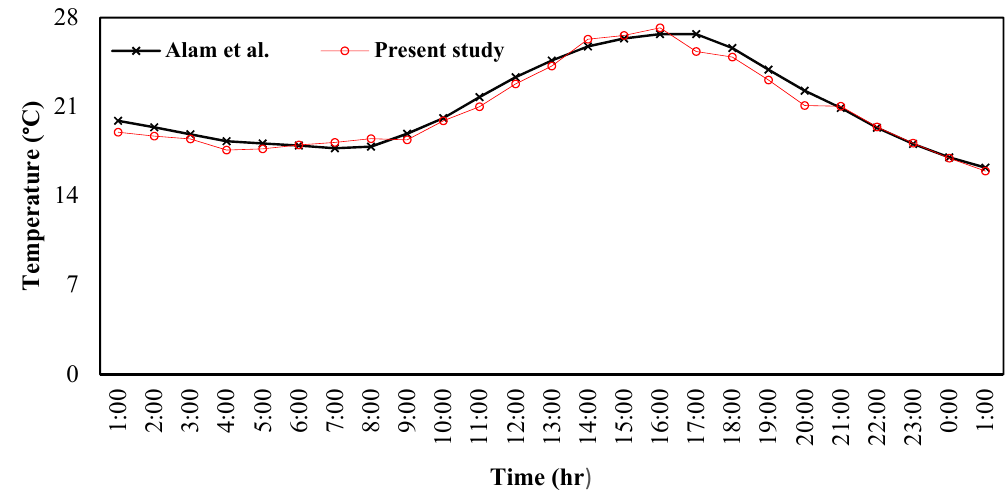
Figure 6. The comparison of the indoor temperature of the single zone building.